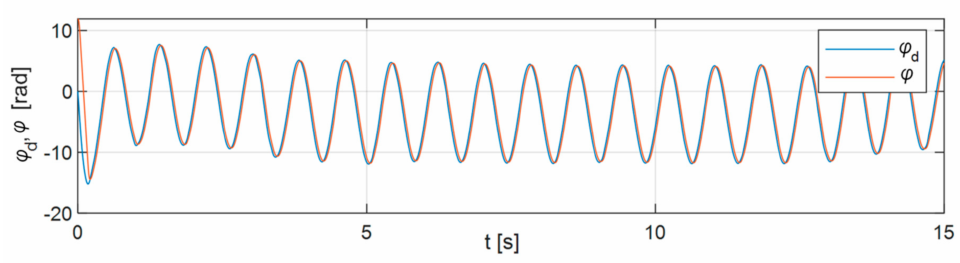
Figure 16. Set ϕ d and realized ϕ positions of the active part as functions of time.